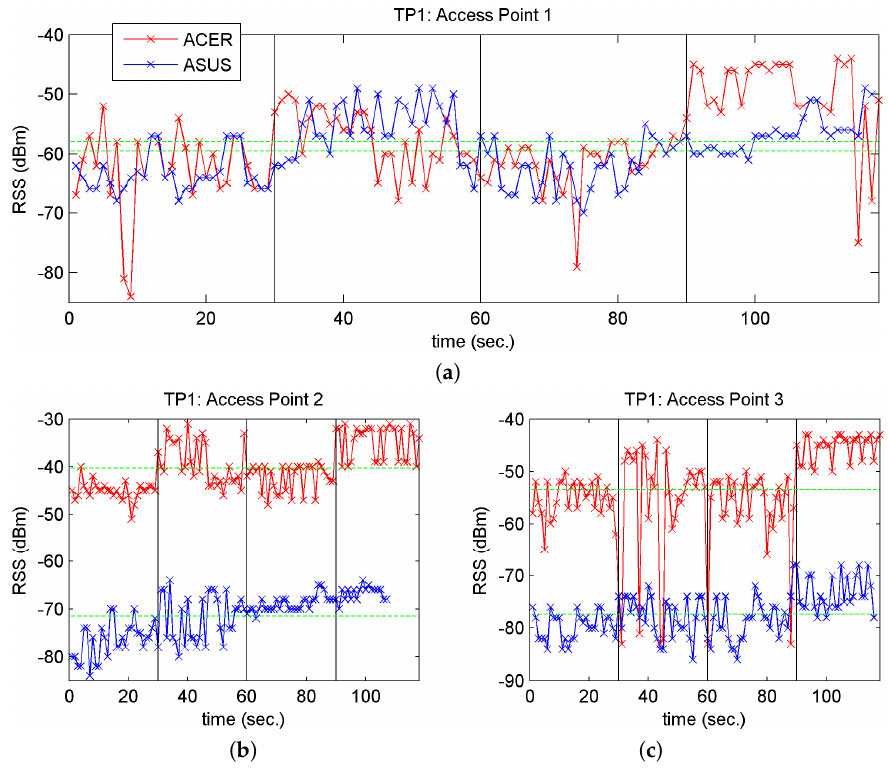
Figure 7. RSS vs. time for point TP1 and the three APs: ( a ) AP1; ( b ) AP2 and ( c )